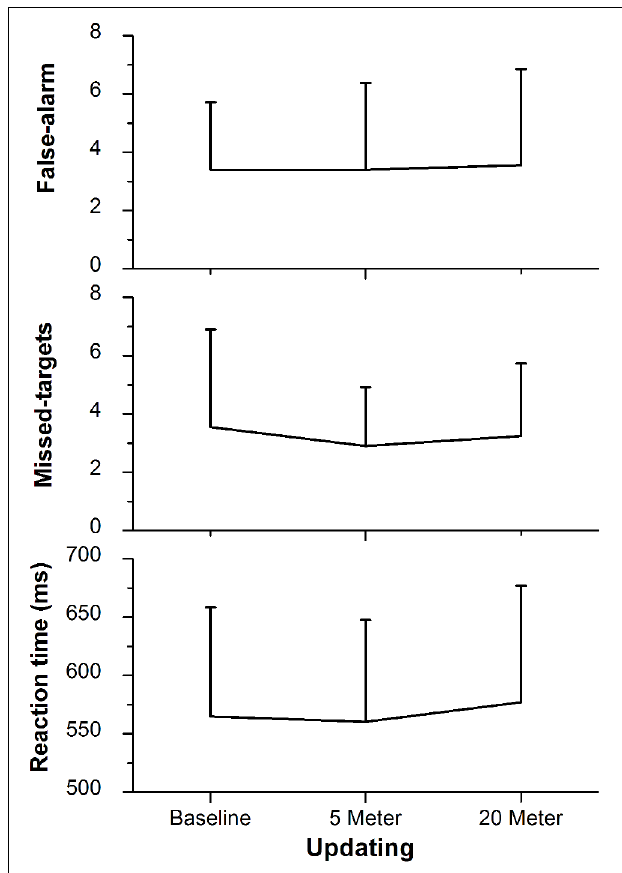
FIGURE 4 | 2-back task performance (i.e., updating) with the lower panel representing the reaction time, the middle panel representing the amount of missed target letters, and the upper panel representing the false-alarm rate. Values representing the arithmetic mean and error bars indicate the corresponding standard deviations.